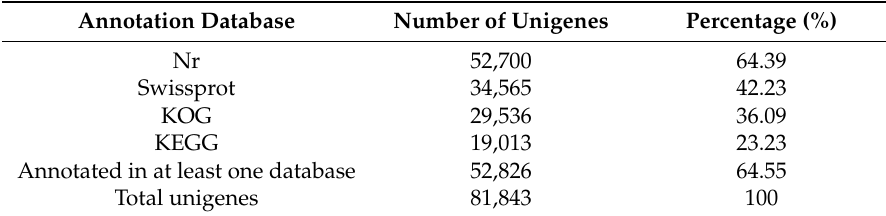
Table 3. Functional annotations of M. canadensis unigenes.